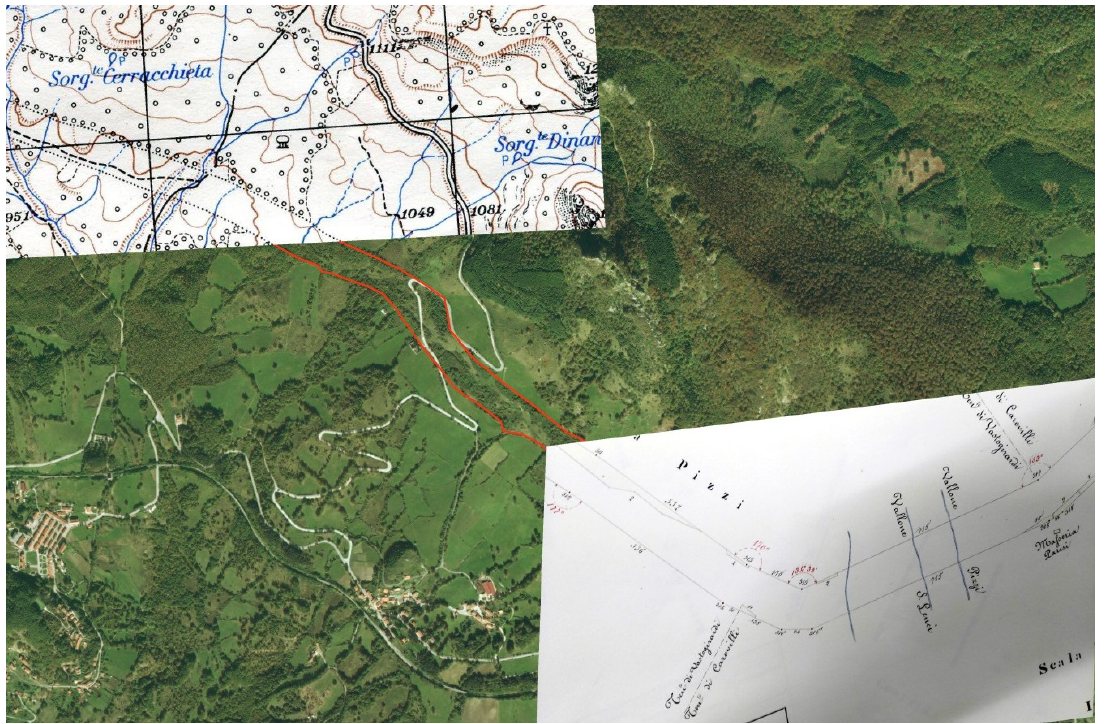
Figure 8. Example of georeferencing through interpretation of three different sources in the territory of Vastogirardi.